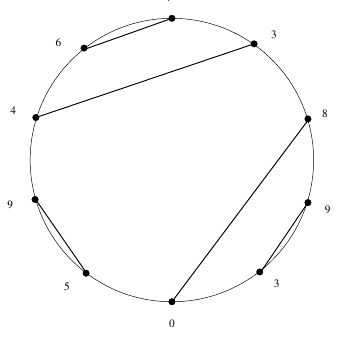
Fig. 1: Illustration of HM ATCHING